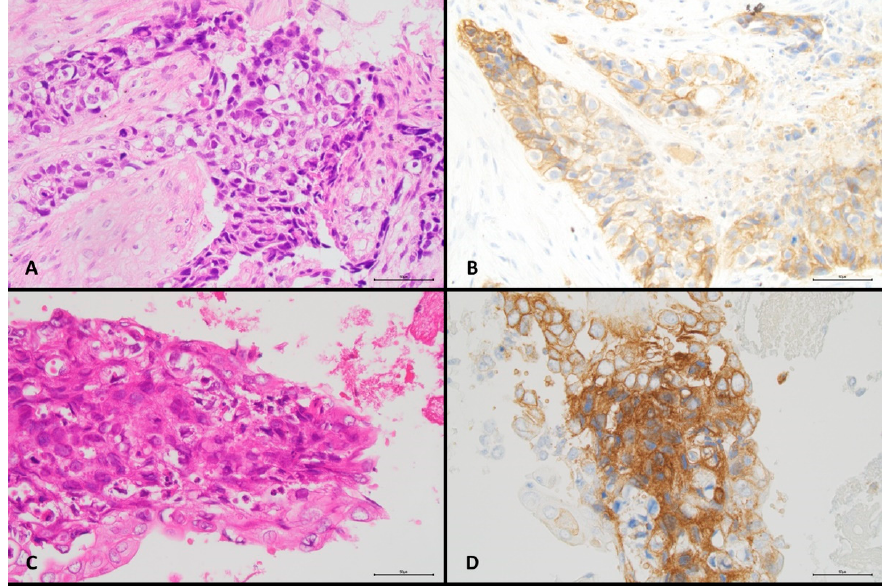
Figure 1. Concordant PD-L1 reactivity in paired histological and cytological specimens from a lung squamous cell carcinoma (original magnification ×400). ( A ) Bronchial biopsy, H&E staining, >500–1000 cells. ( B ) Bronchial biopsy, PD-L1 immunostaining, ≥ 50% positive malignant cells. ( C ) Bronchoalveolar lavage, H&E staining, >300–500 cells. ( D ) Bronchoalveolar lavage, PD-L1 immunostaining, ≥ 50% positive malignant cells.